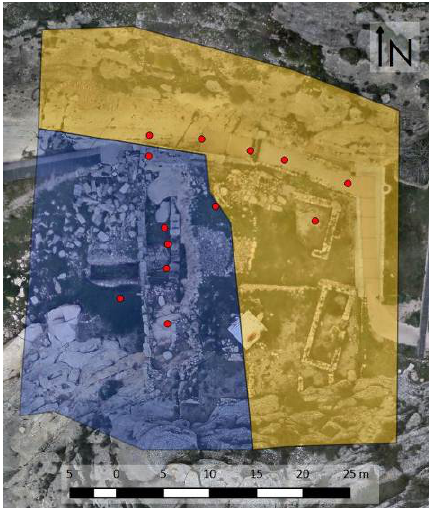
Figure 4. TLS stations